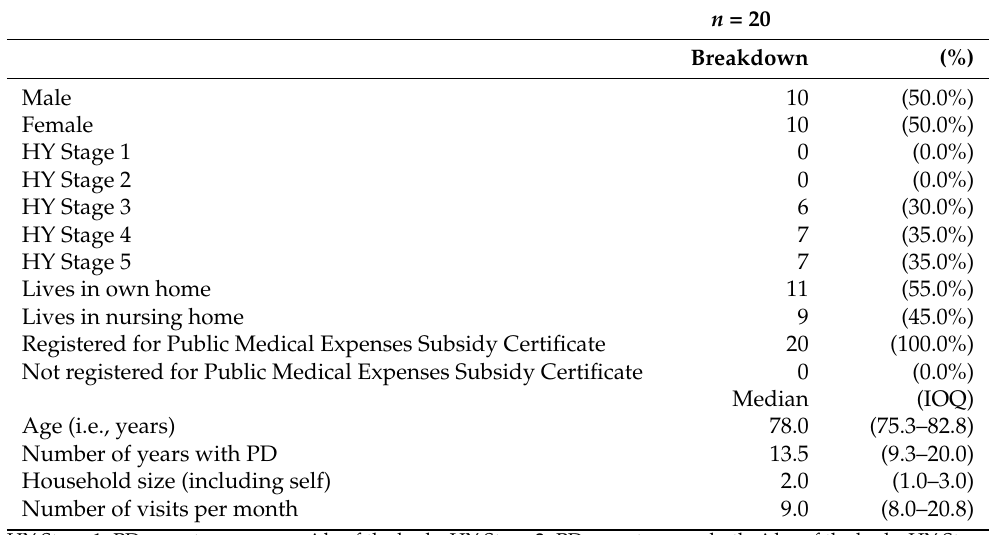
Table 1. Descriptive statistics for patients with Parkinson’s disease.